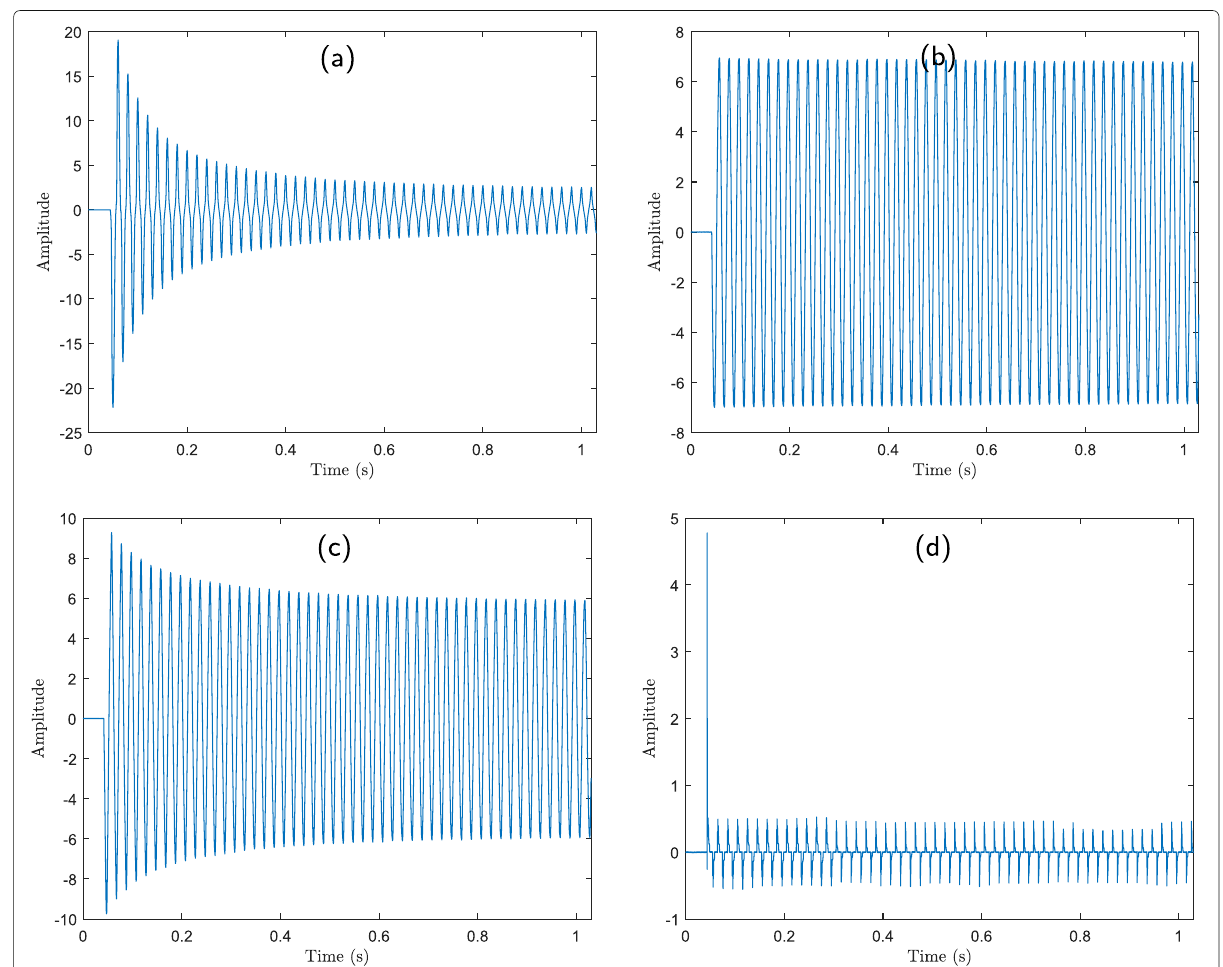
Fig. 16 Four examples of turn-on transient signals. a Drill, b hair drayer, c paint stripper, and d fluorescent lamp. Note the different envelope shapes for the different appliances, which gives different minimum radii of curvature